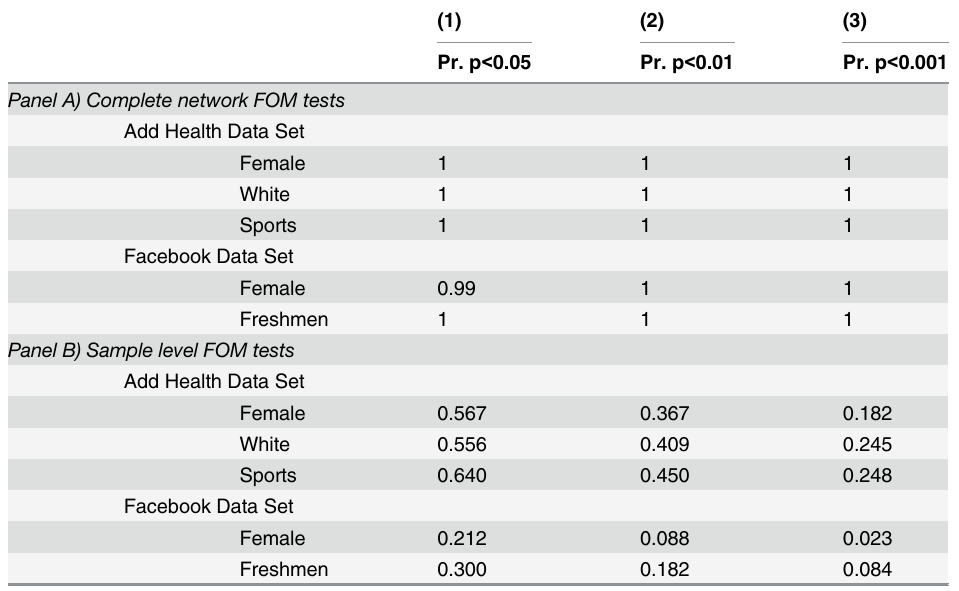
Table 2. Descriptive statistics of First Order Markov (FOM) tests on Add Health and Facebook Net- works, by analysis level and